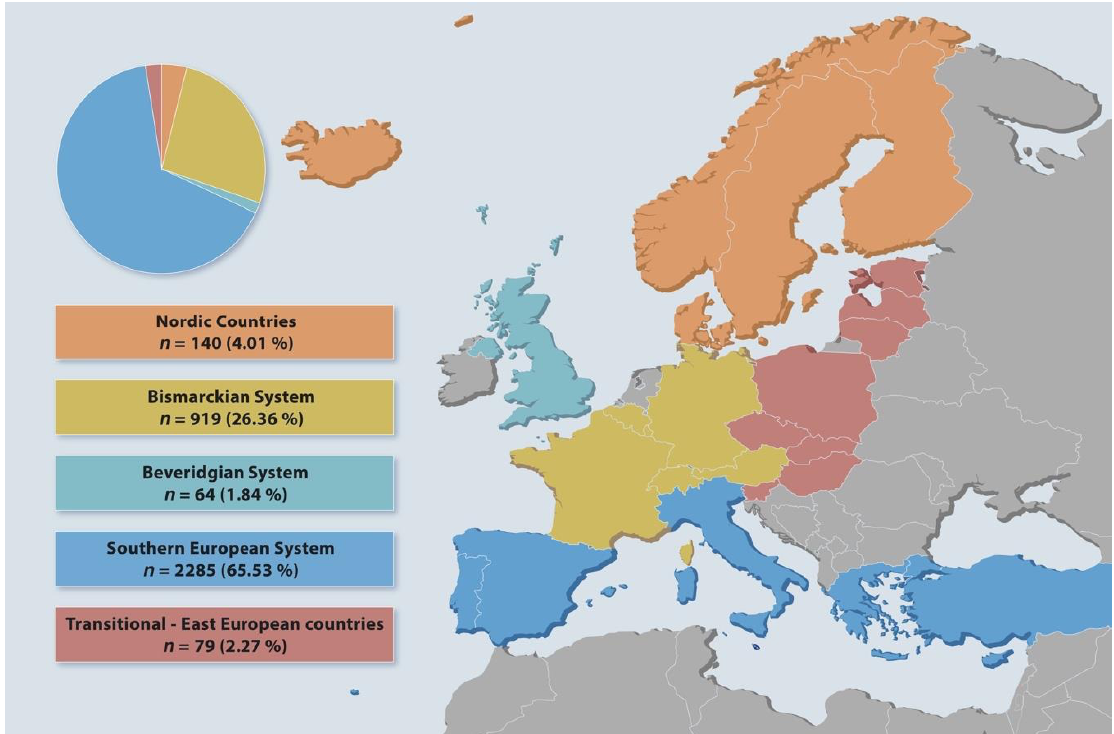
Figure 1. Map of Europe with information on the type of health care systems of the study participants.